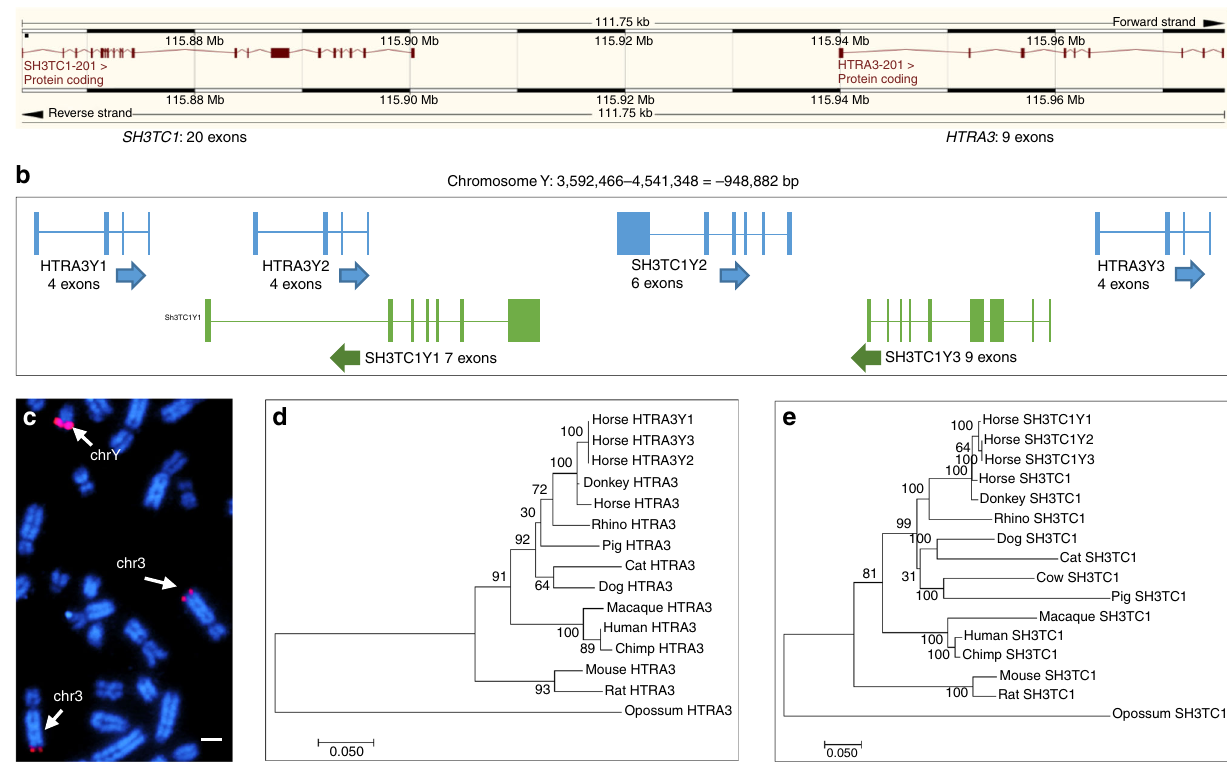
Fig. 5 Acquisition of MSY genes by transposition from chr3. a Adjacent location of single SH3TC1 and HTRA3 in horse chr3 (http://www.ensembl.org/); b Close location of 2 copies of SH3TC1Y and 3 copies of HTRA3Y in eMSY sequence map; c FISH with eMSY BAC 139C20 containing SH3TC1Y and HTRA3Y in horse metaphase chromosomes; hybridization signals are present in eMSY and chr3qter (arrows); scale bar 1 µ m; d – e Maximum likelihood phylogeny with bootstrap support values showing the clustering of three copies of SH3TC1Y and HTRA3Y in eMSY with their autosomal paralogs indicating